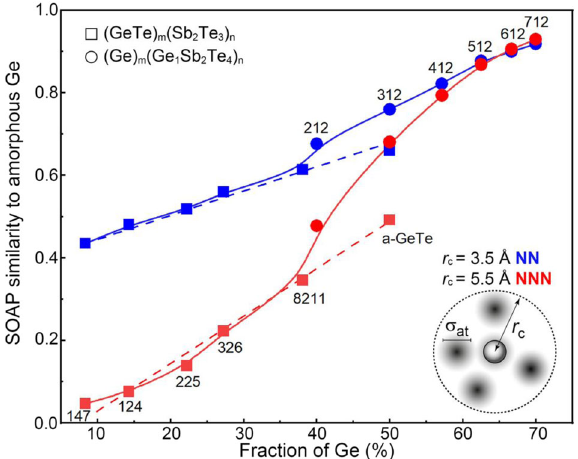
Fig. 4 SOAP analysis. Structural similarity of the various amorphous phases to amorphous Ge, as quanti fi ed by the SOAP kernel (see “ Methods ” ). The normalized SOAP similarity represents the global similarity of all Ge-centered motifs in amorphous stoichiometric GST and GeTe (squares) and Ge-rich GST (circles), with respect to amorphous Ge (quenched using the same protocol); a value of 1.0 indicates indistinguishable environments (up to a given cut-off radius). More speci fi cally, for a given atom in one amorphous GST or GeTe sample, a SOAP similarity value with respect to one atom in one amorphous Ge model is calculated, and then averaged over all atomic environments in three independent amorphous Ge models. The kernel similarity is then averaged over all atomic environments in a given amorphous sample of GST or GeTe, and subsequently, over three independent amorphous samples. The lower inset sketches the smoothed atomic neighbor density that is used as the basis for SOAP analysis. The radial cutoffs are 3.5 Å for short- range (NN — nearest neighbor, blue) and 5.5 Å for medium-range (NNN — next nearest neighbor, red) similarity to amorphous Ge.